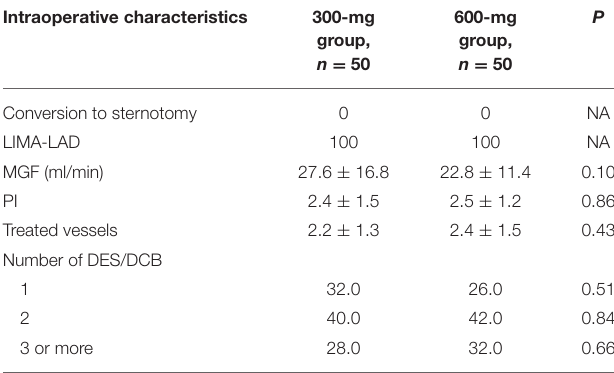
TABLE 1 | Baseline characteristics of patients according to the study groups. TABLE 2 | Intraoperative variables of patients according to the study